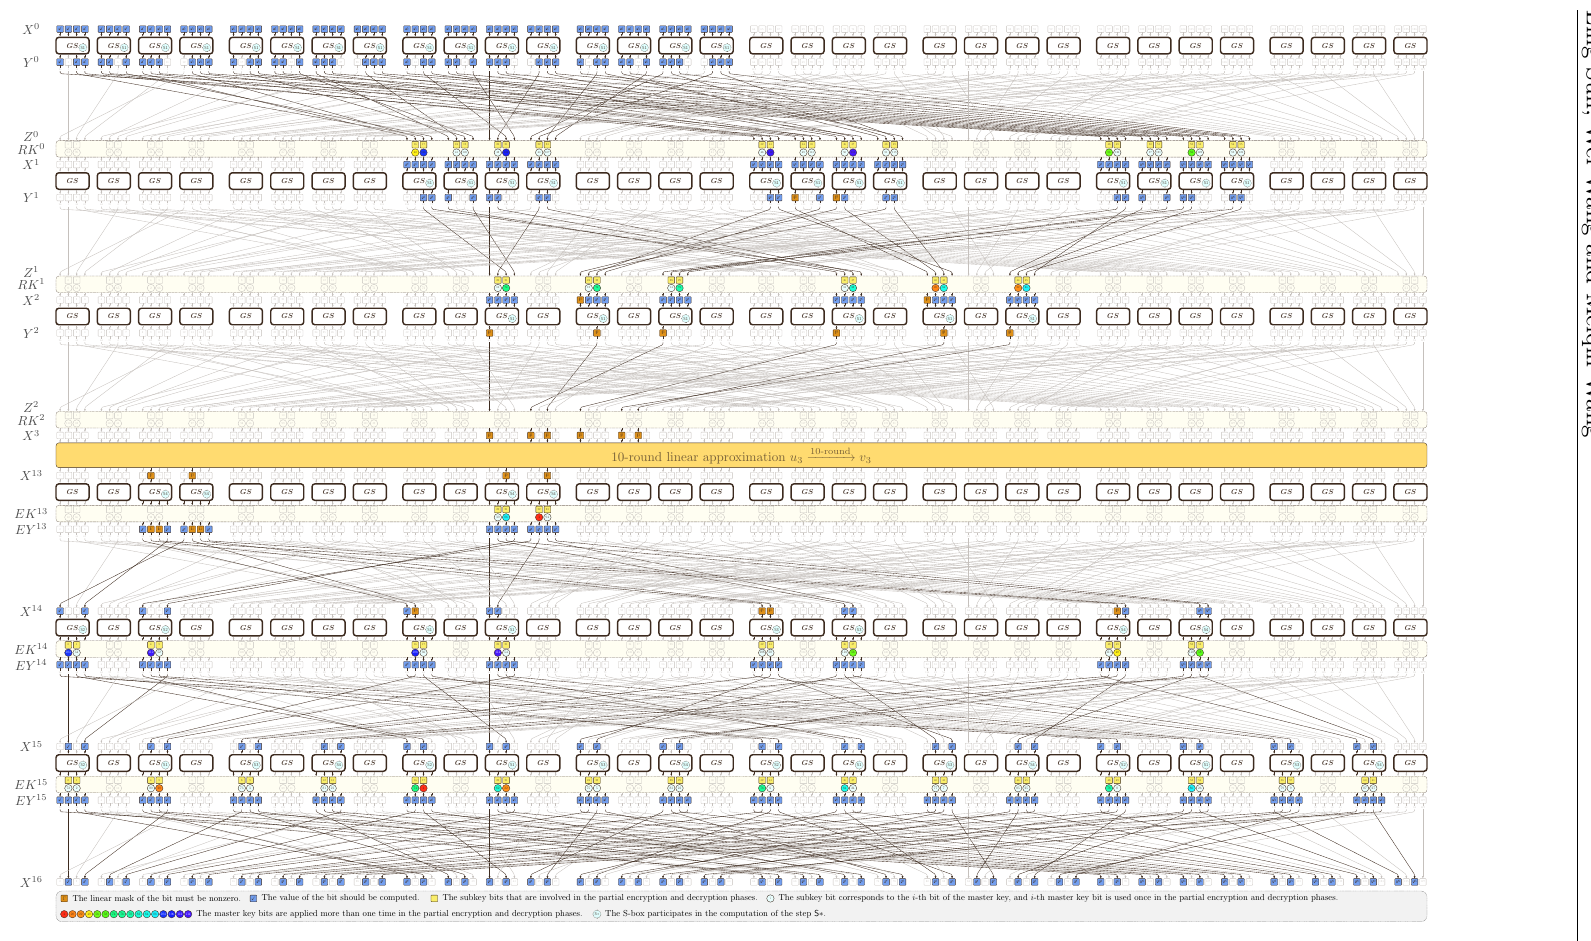
Figure 9: Key-recovery attack on 16-round GIFT-128 in HyENA